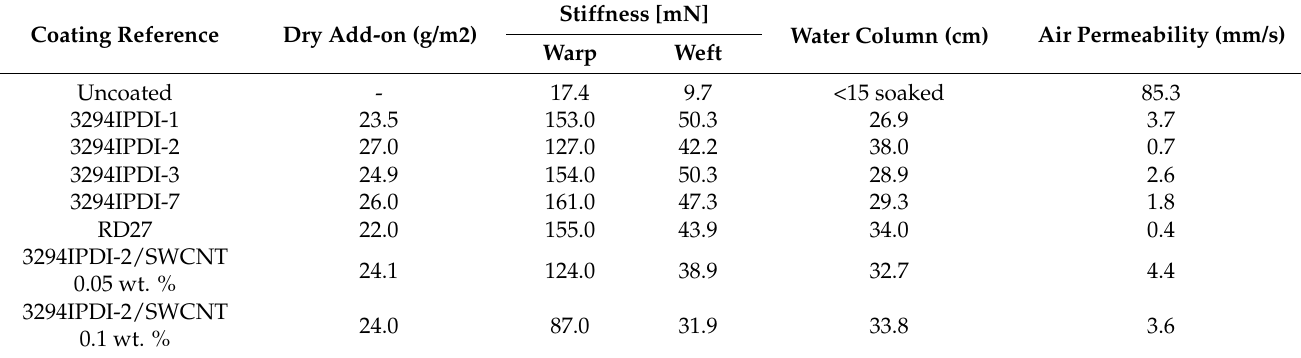
Table 9. Stiffness, water column, and air permeability of UPRON fabrics uncoated and coated by knife coating procedure. Coating